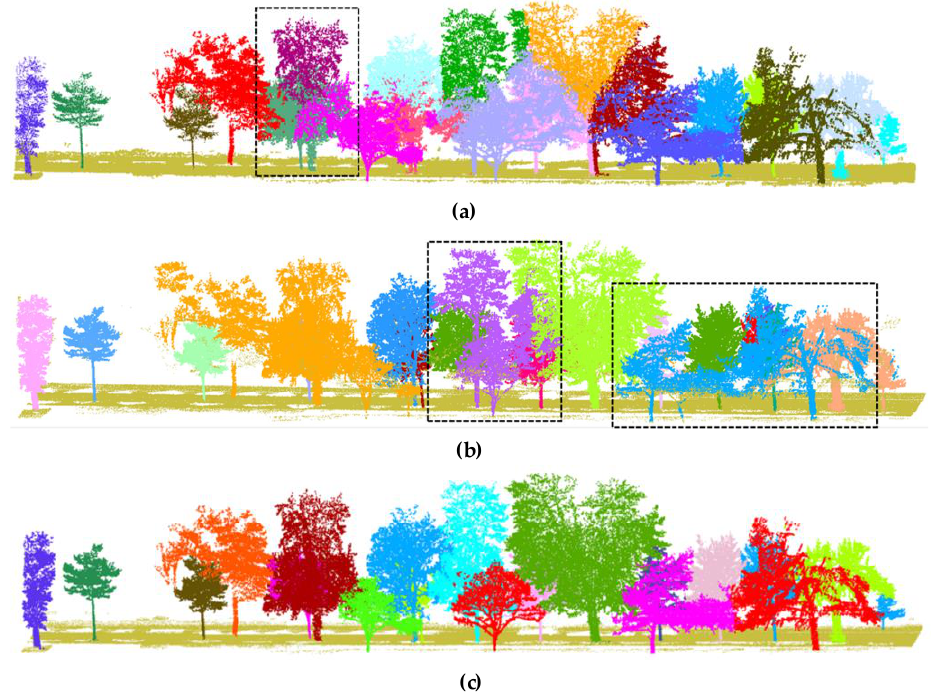
Figure 16. Comparison results in Scene 5. ( a ) Clustering based method [44]. ( b ) 3D Forest method [30]. ( c ) Our method. Table 2. Quantitative comparison results on four